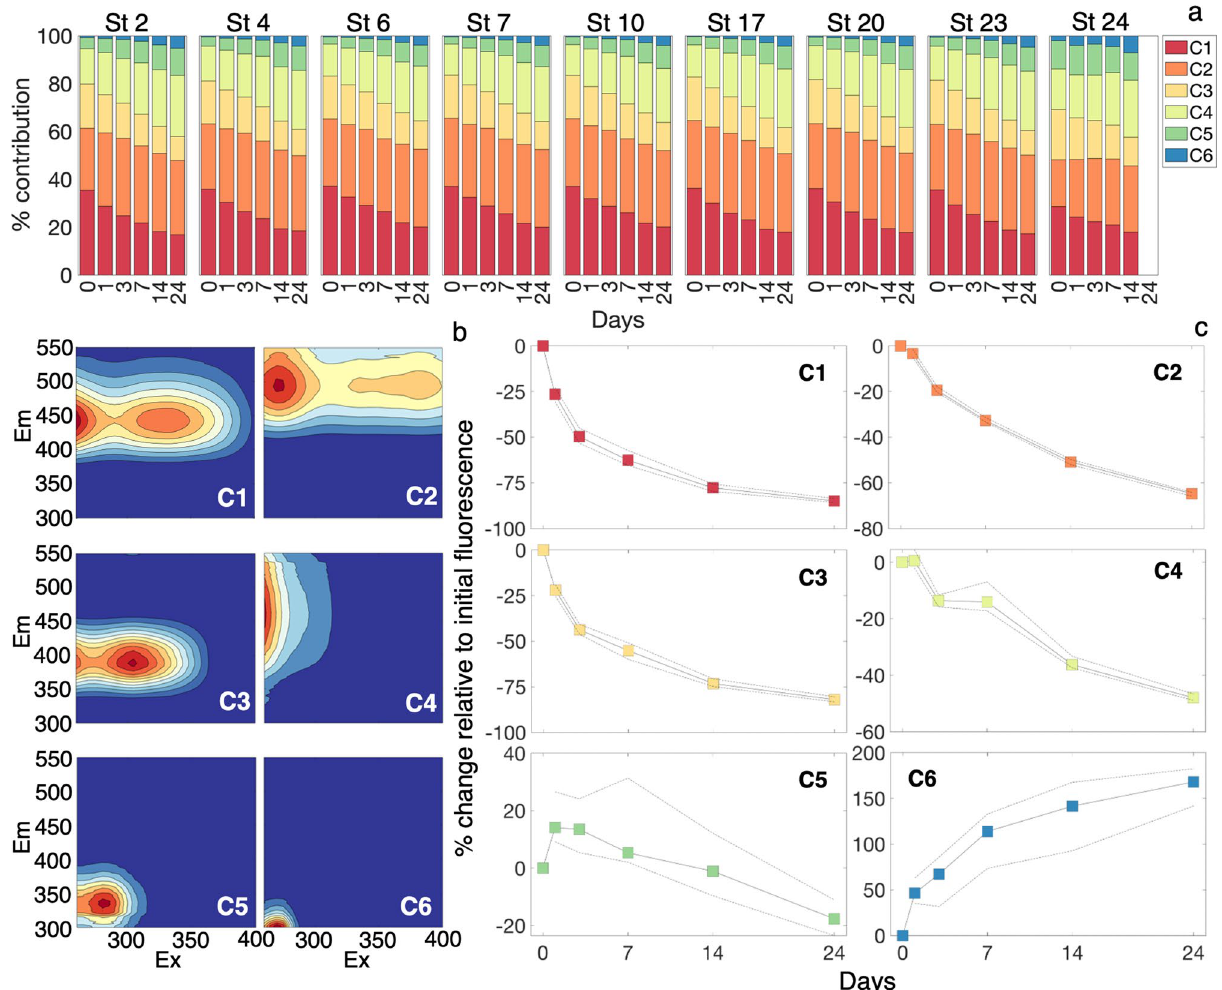
Figure 2. ( a ) PARAFAC component percent contribution to total fluorescence (Eq. 4) over the time course of photobleaching experiments. ( b ) Component fingerprints for the six component PARAFAC model. The same figure with more spectrally-resolved axes can be viewed in the “Supplemental Material” (Fig. S3). ( c ) Percent changes in individual PARAFAC components due to photobleaching. The solid lines and colored squares indicate the median change across all stations and replicates and the dashed lines indicate the first and third quantile ranges for all stations and replicates.